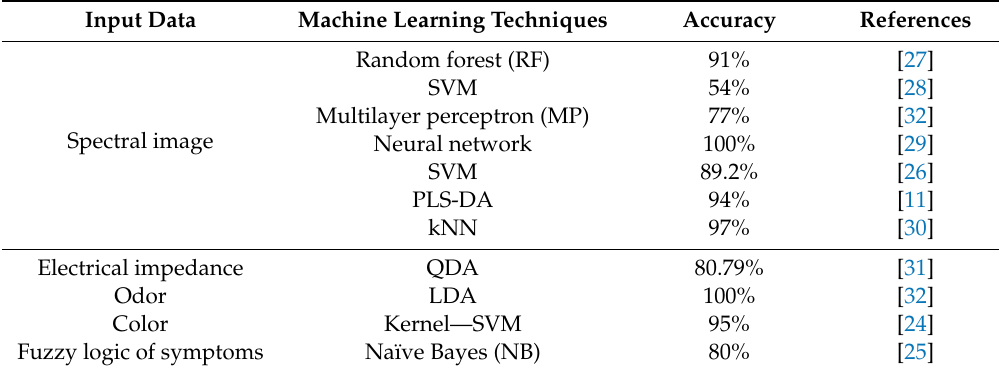
Table 1. List of machine learning (ML) techniques used for Ganoderma boninense